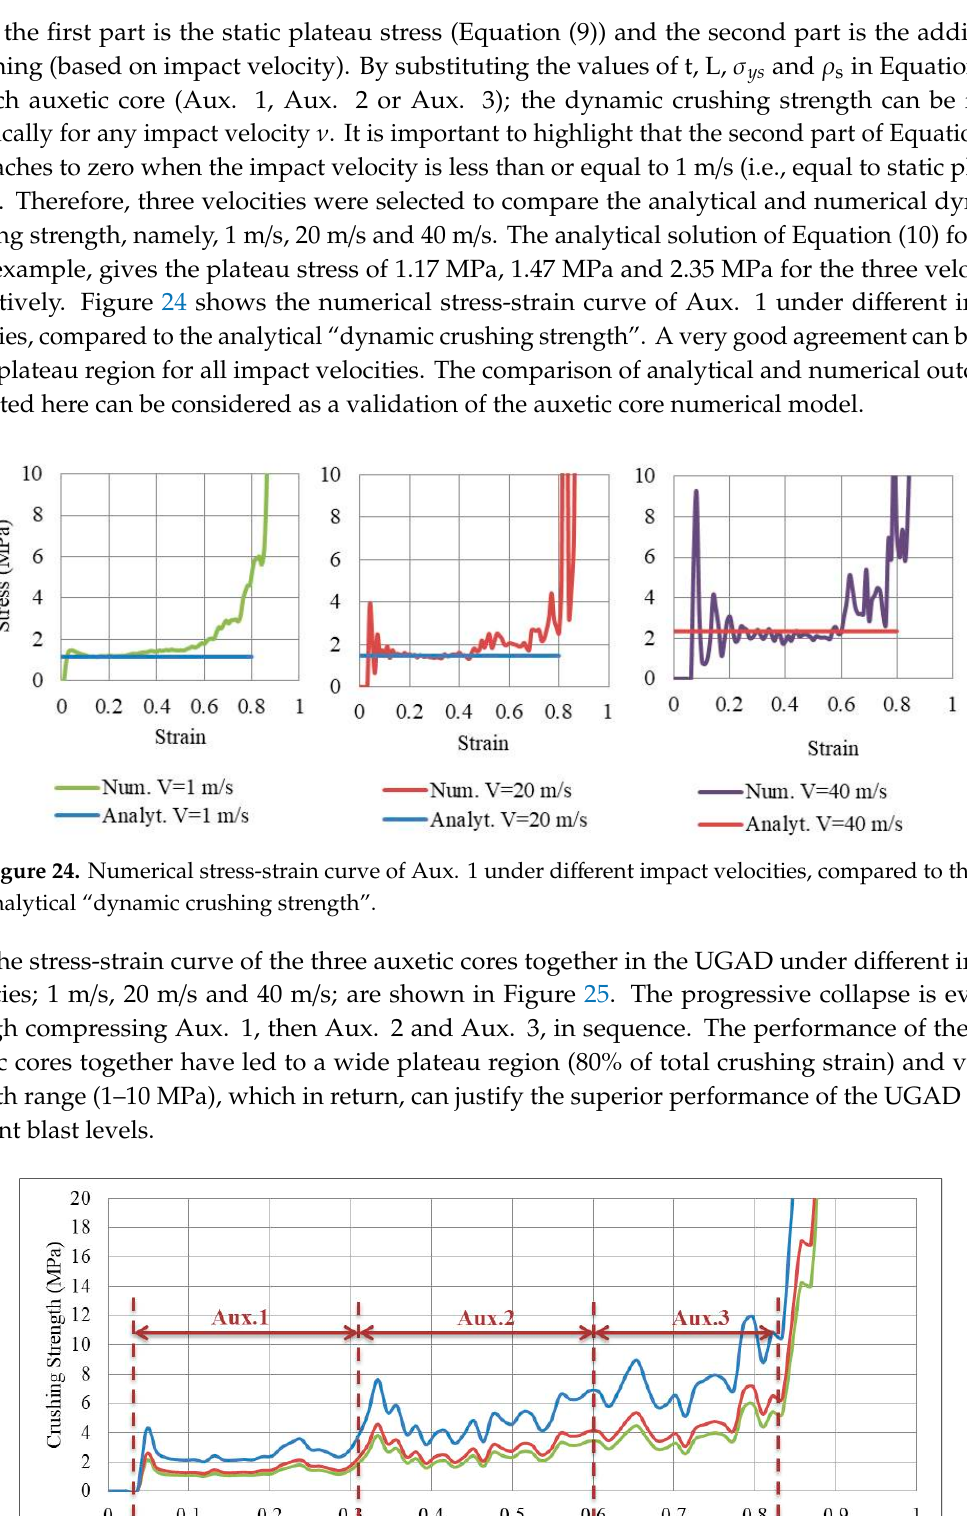
Figure 25. Numerical stress-strain curve of the three auxetic cores together in the UGAD under different impact velocities, 1 m/s, 20 m/s and 40 m/s.